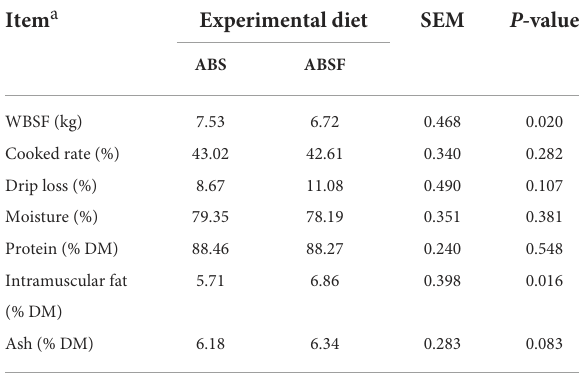
TABLE 6 WBSF and chemical composition of steak samples of goats fed a total mixed ration supplemented with anthocyanin-rich black cane silage (ABS) or anthocyanin-rich black cane silage treated with ferrous sulfate heptahydrate